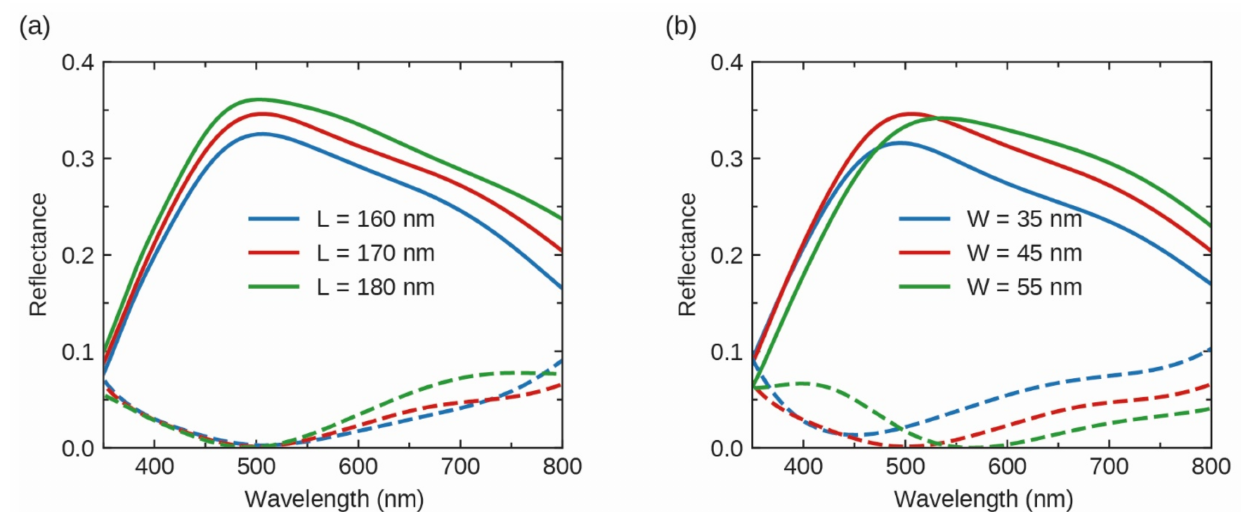
Figure A3. In ( a ), the length L and in ( b ) the width W of the nanobrick metasurface used in Figure 3a was detuned by ± 10 nm to test the stability against fabrication imperfections. For the original and detuned structures, the cross- and co-polarized reflectance amplitude is indicated with solid and dashed lines, respectively. In ( a ), the efficiency increased with the nanobrick length; however, longer bricks led to smaller gaps between them. To keep a balance between efficiency and fabrication feasibility, a length of 170 nm was chosen for the final design. The cross-polarization efficiency at 500 nm was decreased by 2% for a 10 nm smaller length. Furthermore, it was the highest for the chosen width of 45 nm and the lowest with 3% less for a 35 nm width ( b ).